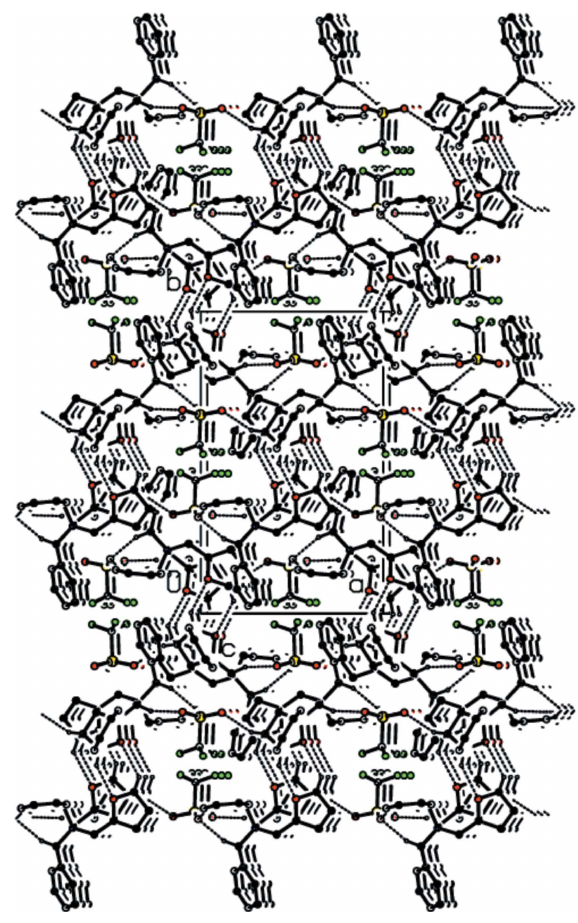
Figure 6 Packing of the title salt 1 viewed along the c- axis direction with C—H (cid:2)(cid:2)(cid:2) O hydrogen bonds shown as dashed